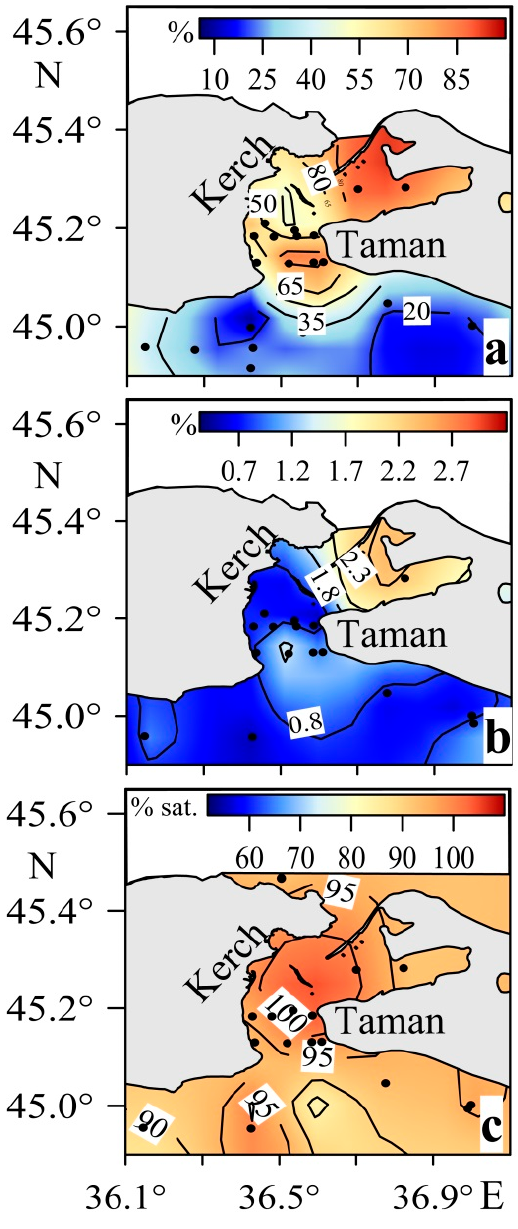
Figure 7. Spatial distribution of the clay fraction ( a ) and C org ( b ) in the sediment surface layer, and ( c ) degree of oxygen saturation of the bottom water layer of the Kerch pre-strait region. In the region of the Kerch pre-strait from the Sea of Azov (St. 115, depth ~10 m), the oxygen concentration in the bottom water layer was 217 µ M (91% sat.) (Figure 7c), and on the sediment surface (0 mm), it decreased to 133 µ M (Figure 8a). The predominant components of the pore waters were the reduced forms of iron and manganese. The Fe(II) concentration reached 2700 µ M (Figure 8a), with an average value of 803 µ M. Two layers of Mn(II) concentrations were noted: 1–15 mm and 36–76 mm (Figure 8a). The concentration of Mn(II) in the 1–15 mm layer increased from 236 to 854 µ M (average value of 538 µ M), and in the 36–76 mm layer, it decreased from 1042 to 658 µ M (average value of 853 µ M). Iron monosulfide (FeS) was also